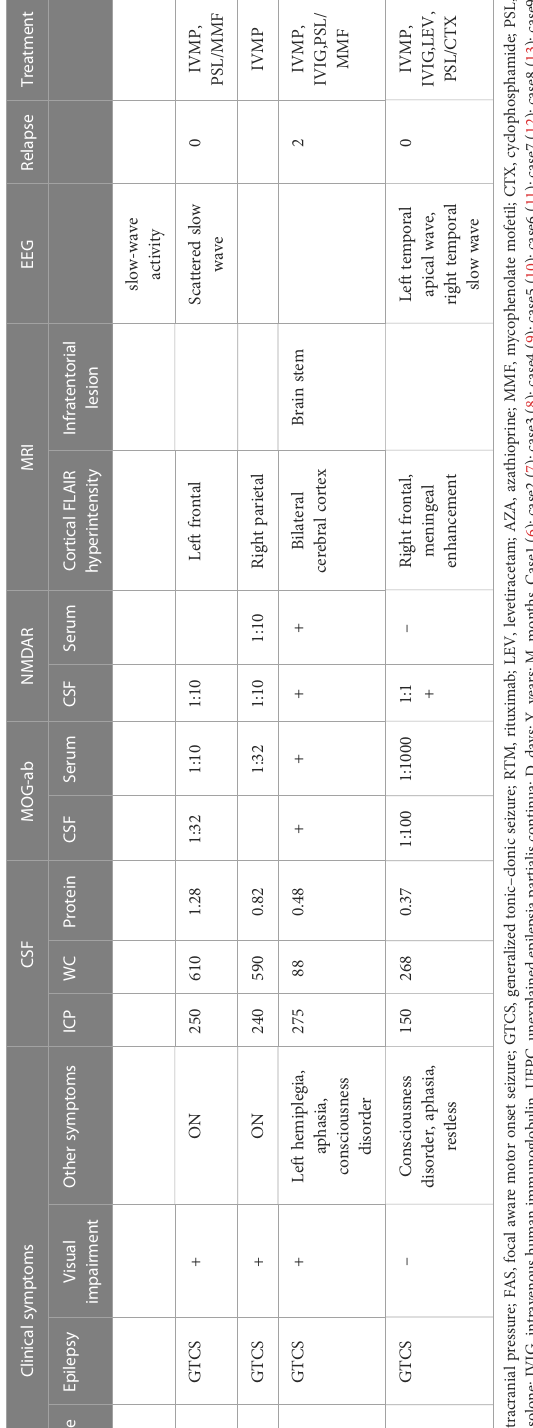
antibodies (serum, 1:1000; cerebrospinal fl uid, 1:100), autoimmune encephalitis-associated autoantibodies, and anti-NMDAR antibodies (serum, 1:10; cerebrospinal fl uid, 1:10). The patient was then administered intravenous immunoglobulin (0.4g/kg/d for 5 days) and intravenous methylprednisolone (1g/d for 3d, 0.5g/d for 3d, and 0.12g/d for 3d). This resulted in gradual improvement in the above symptoms. Repeat cerebral MRI 28 days after admission showed the disappearance of the FLAIR-hyperintense lesion in the right frontal cortex, while a CSF examination indicated 20×10 6 /L leukocytes and 0.30 g/L protein. A fi xed cell assay was positive for anti-NMDAR antibodies (CSF, 1:1+) and MOG antibodies (serum 1:10+, CSF 1:1+). In addition, results were negative for all of the following antibodies: anti-aquaporin-4 (AQP4), anti-NMDAR, anti-leucine-rich glioma inactivated 1 (LGI1),